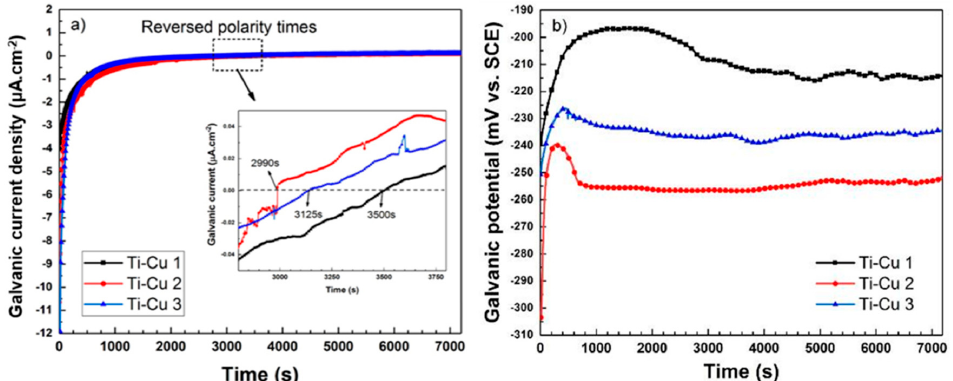
Figure 13. ( a ) Current and ( b ) potential curves of galvanically polarized Ti/Cu couple in 3.5 wt.% NaCl corrosive solution with three repetitions; polarity reversal time or change in the net flow of electrons occurred after approximately 1 h.